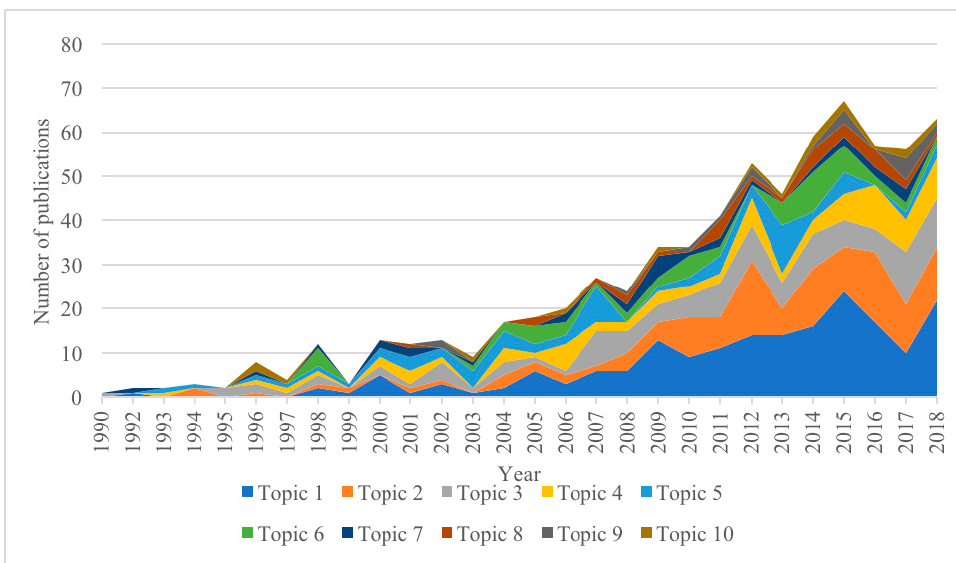
Figure 5. Changes in research topic development.